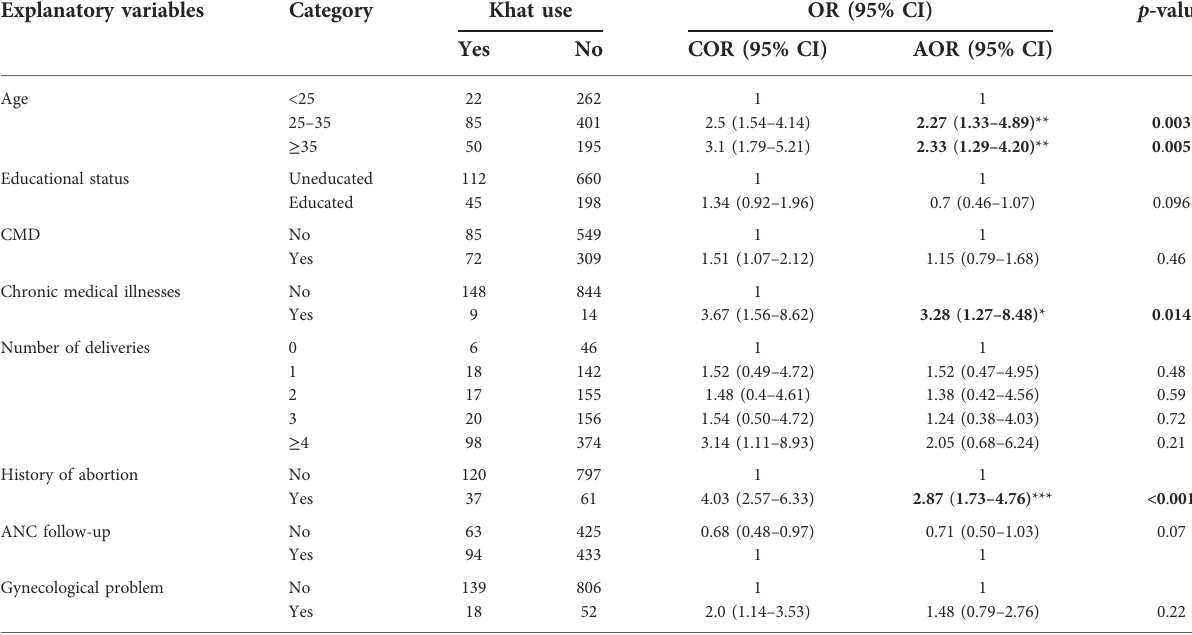
TABLE 5 Factors associated with khat use among pregnant women in Kersa and Haramaya HDSS sites,